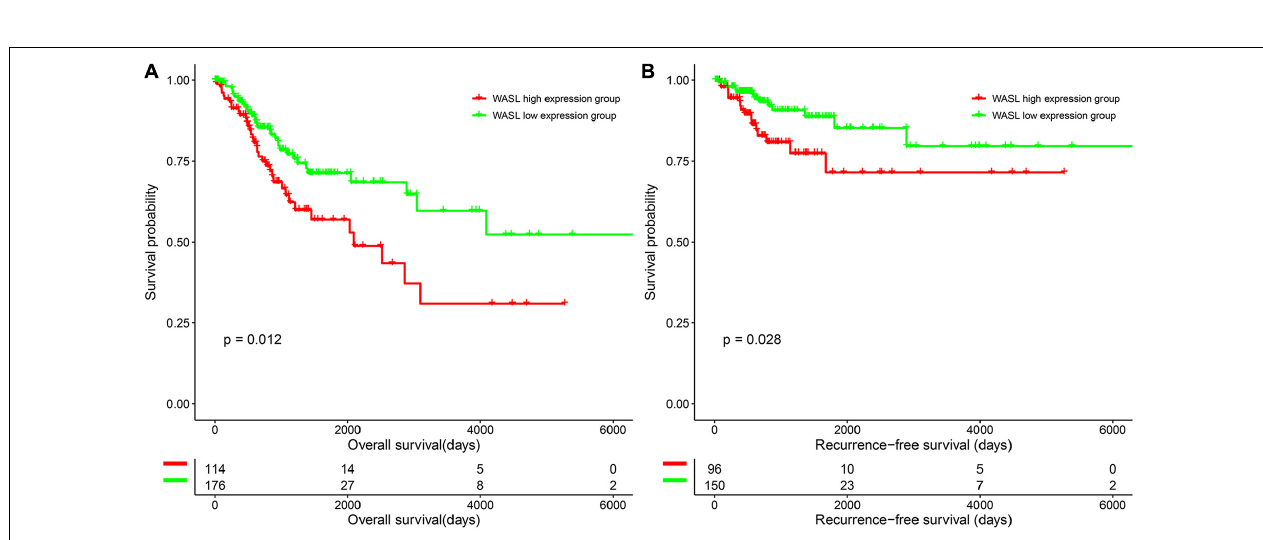
FIGURE 2 | Survival differences of patients in the WASL low expression group and WASL high expression group. (A) Overall survival. (B) Recurrence-free survival.